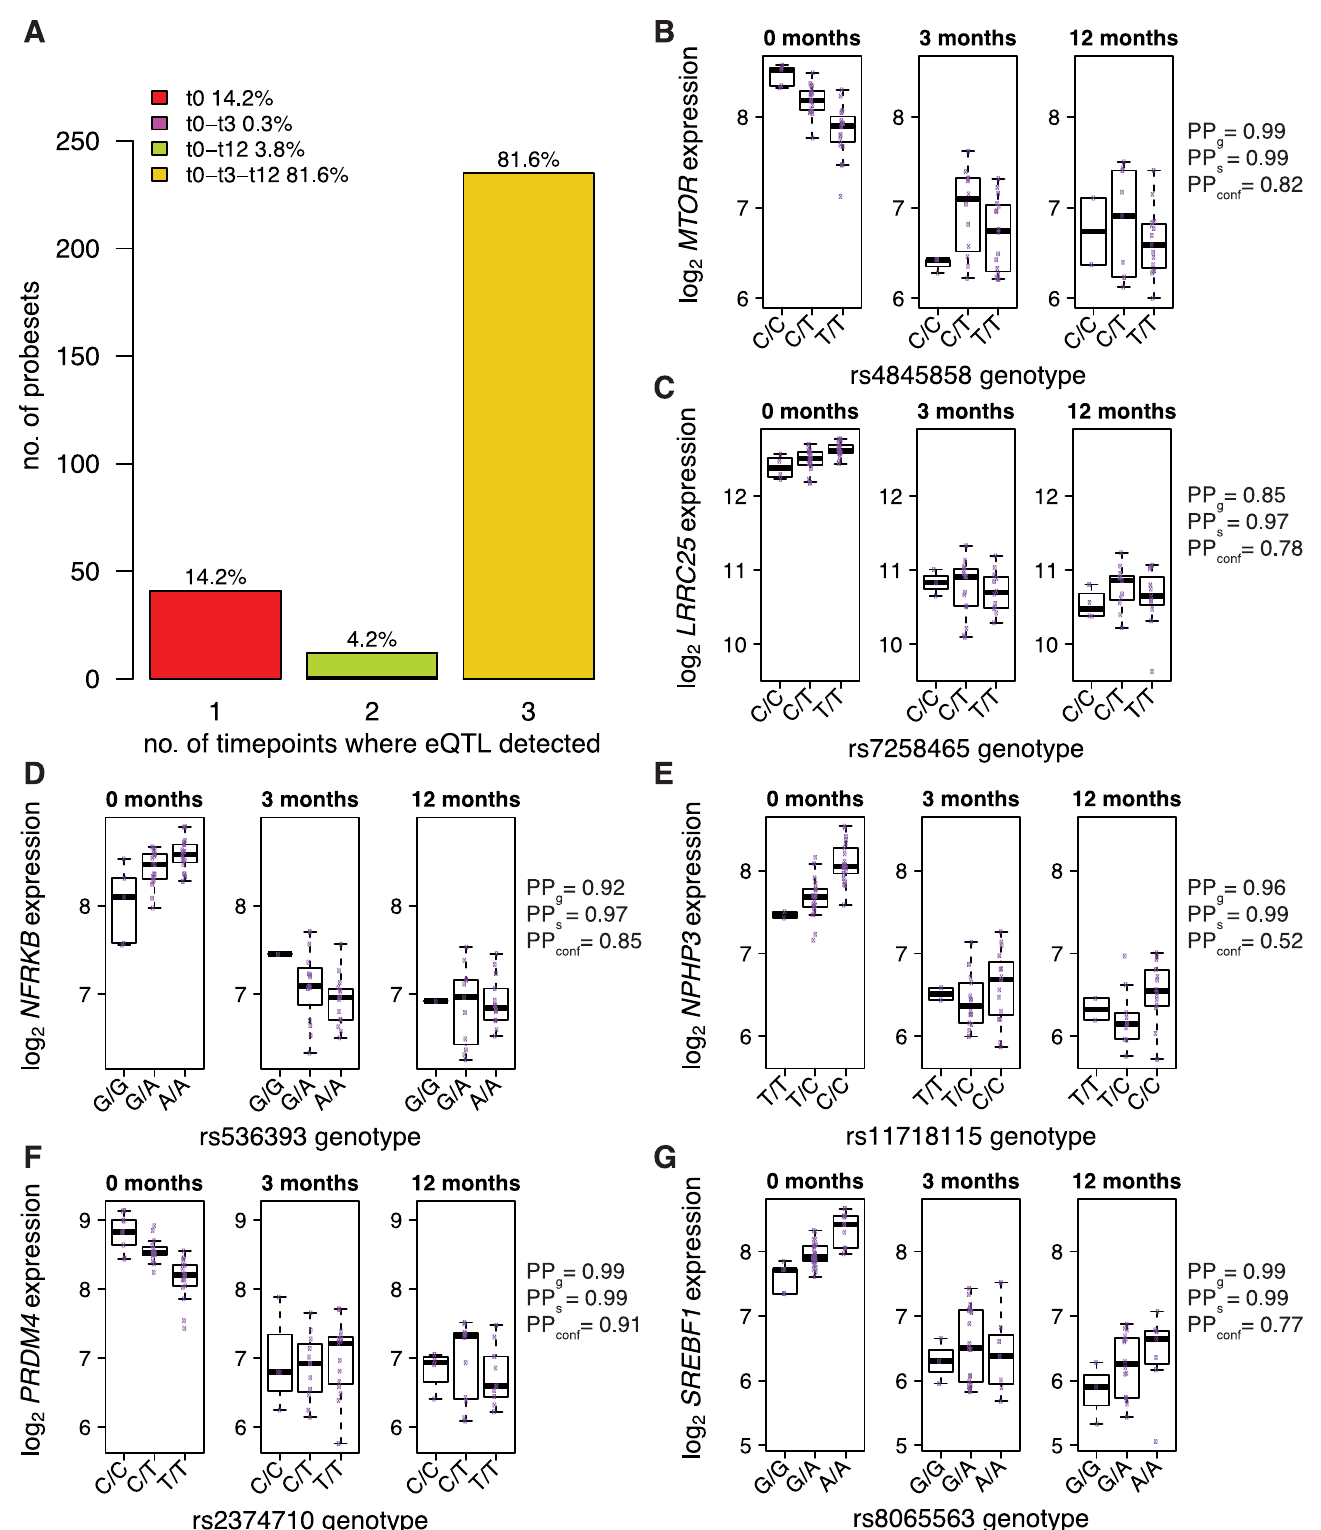
Fig 5. eQTLs present in active inflammatory disease can resolve after treatment. (A) Number of probesets with eQTLs in neutrophils in active AAV and after treatment. (B-G) Examples of neutrophil eQTLs present in active vasculitis which disappear with treatment. PP g = posterior probability that the gene